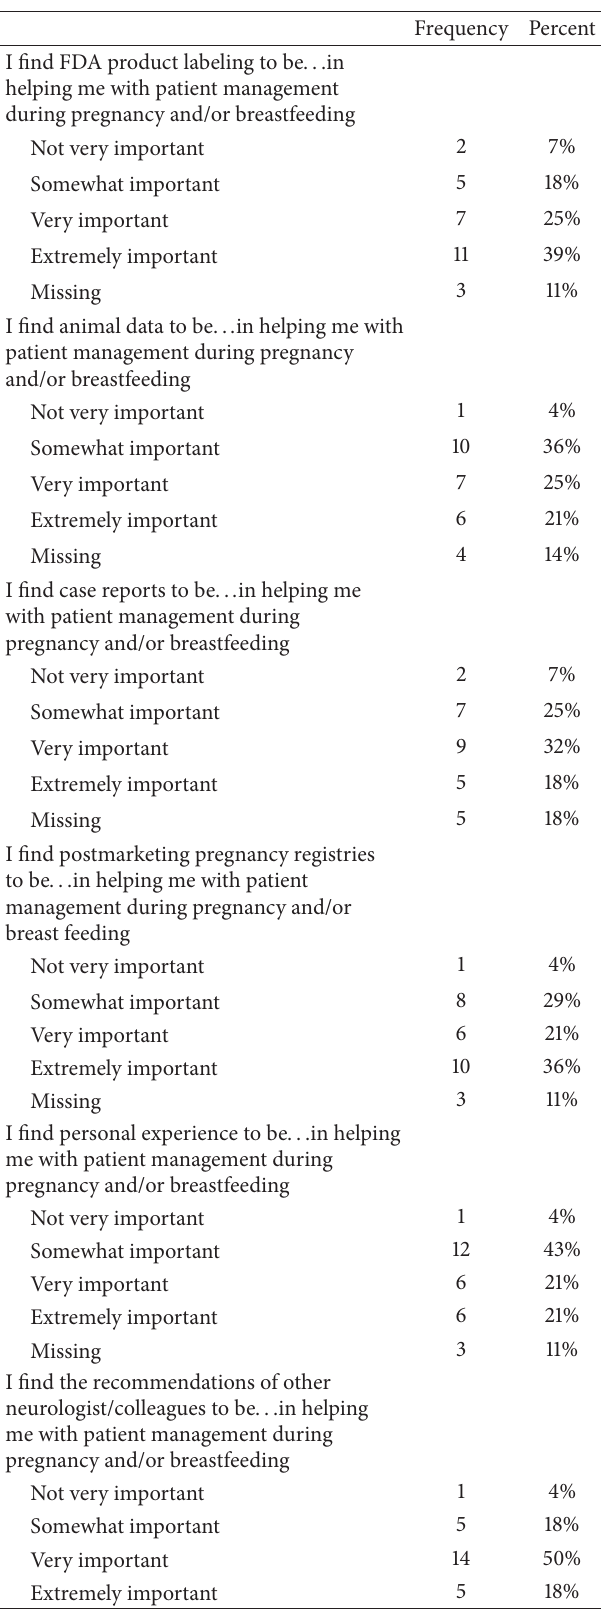
Table 2: Sources of information for patient management during